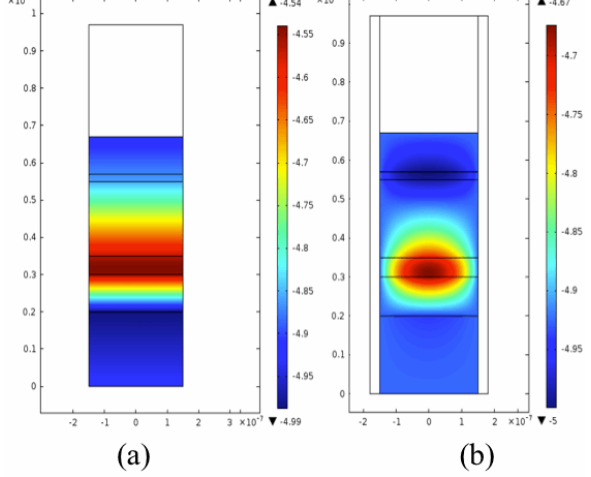
Figure 2. Electric potential generated in a-Si solar cell without pas- sivation (a) & electric potential generated in a-Si solar cell with sidewall passivation (b).